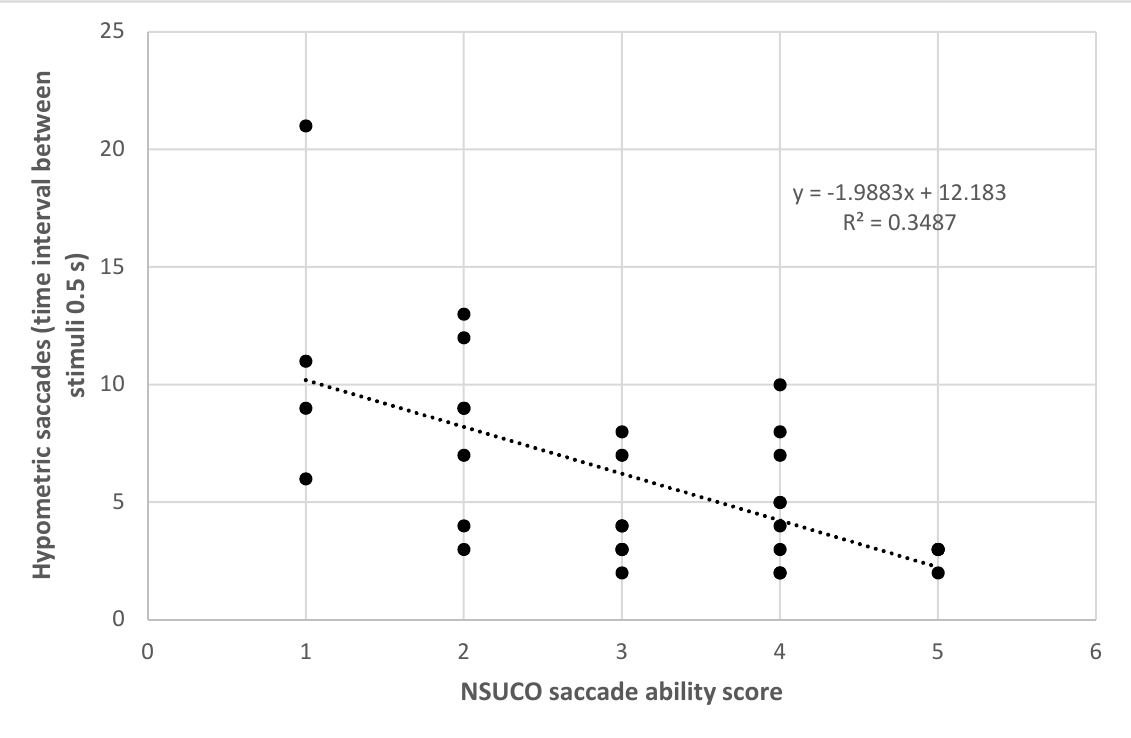
Figure 4. Scatter plot showing the relationship between number of hypometric saccades detected with the eye tracker using a time interval between stimuli de 0.5 s and the NSUCO saccade ability score. The adjusting lines to the data obtained by means of the least-squares fit are shown. Table 4. Summary of the outcomes of the linear regression analysis for these relationships among subjective and objective oculomotor parameters showing statistically significant correlations in the whole sample (Y = objective parameter, X = subjective parameter).